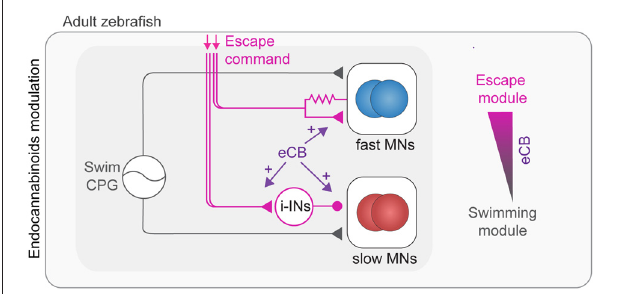
FIGURE 4 | Modulation of adult swimming and escape circuits by endocannabinoids (eCBs). Swimming behavior is generated by speed dependent excitation of MNs by the spinal swim CPG network (gray connections). Activation of the escape network (purple connections) leads to temporary interruption of swim behavior. The escape command leads to a switch from slow to fast MN pools which is mediated by direct excitation of fast (blue) and indirect inhibition of slow MNs (red). The selection of escape over swimming behavior is positively modulated by eCB through enhancement of synaptic